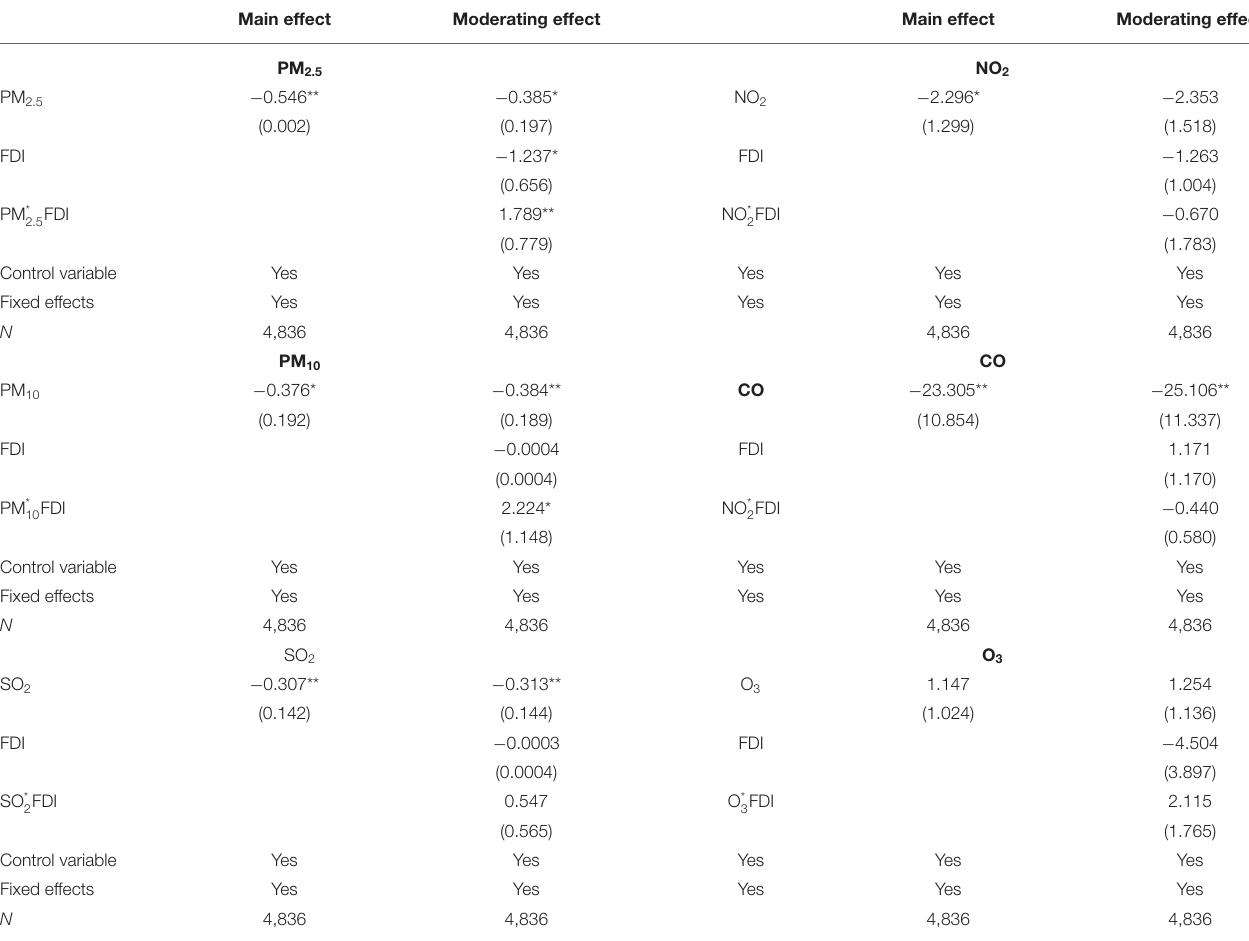
TABLE 4 | Regression results of six major air pollutants as the independent